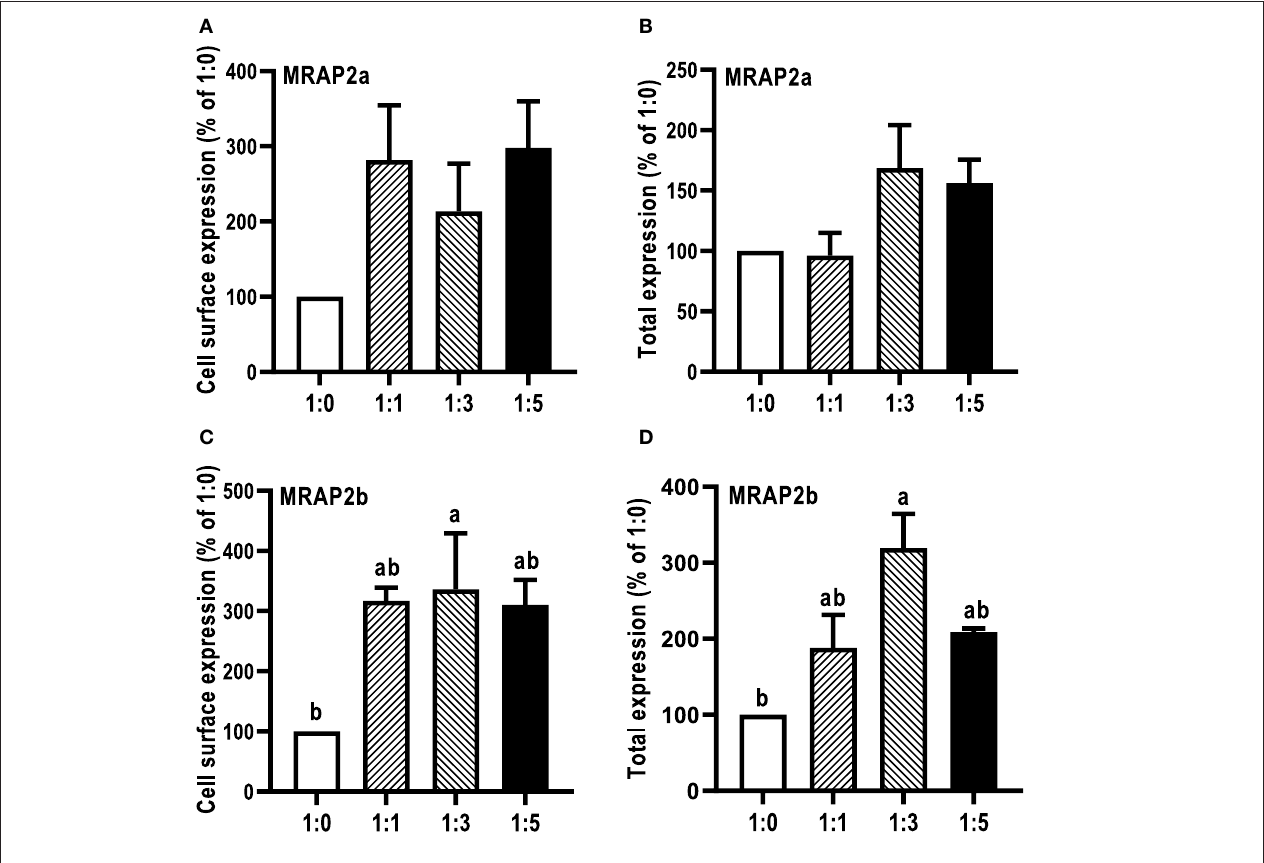
FIGURE 7 | Modulation of caMC4R expression by caMRAP2a or caMRAP2b. Cell surface (A,C) and total expression (B,D) of caMC4R was measured by flow cytometry. HEK293T cells were cotransfected with different ratios of caMC4R/caMRAP2a or caMC4R/caMRAP2b (1:0, 1:1, 1:3, and 1:5). The results were calculated as % of 1:0 group after correction of the background staining (fluorescence in cells transfected with empty vector, pcDNA3.1). Each data point represented the mean ± SEM ( n = 3–4). Different letters indicated significant difference ( P < 0.05) (One-way ANOVA followed by Tukey-test).